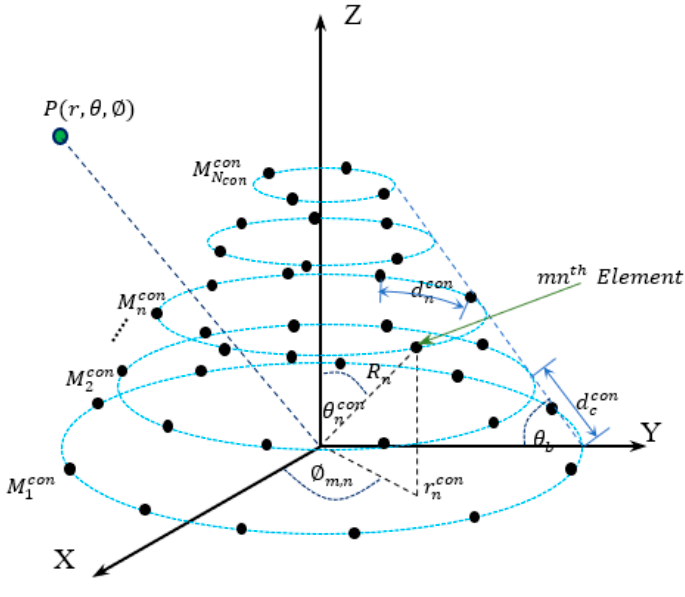
Figure 1. Conical array structure.